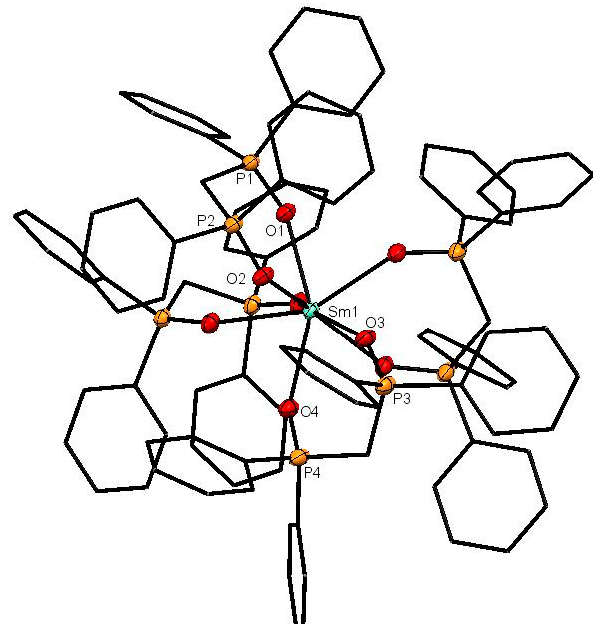
Figure 2. The cation in [Sm(dppmO 2 ) 4 ]Cl 3 . The chloride anions and solvate molecules are omitted. Selected bond lengths (Å): Sm1–O1 = 2.4160(14), Sm1–O2 = 2.4400(15), Sm1–O3 = 2.4358(14), Sm1–O4 = 2.4268(15), P1–O1 = 1.5025(15), P2–O2 = 1.5019(15), P3–O3 = 1.4961(15), P4–O4 = 1.4961(16). Chelate angle O-Sm-O = 72.9° (av).